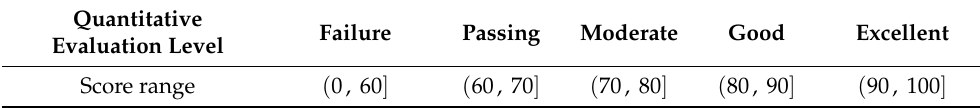
Table 2. Division of the range of gray class values. Quantitative Failure Passing Moderate Good Excellent Evaluation Level Score